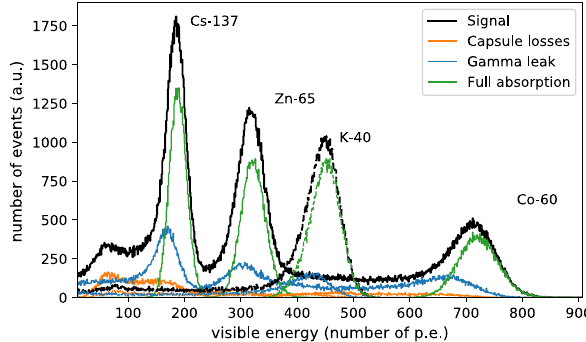
Fig. 12 Simulation of the visible energy spectra (in number of photo electrons) of the gamma sources placed off-axis at a radius of 1.2 and 1.2m over the detector center. The dashed line represents the signal of the 40 K capsule, the solid line of the multi-gamma source. The absorption peaks of the individual isotopes are clearly discernible. The observed spectrum can be understood as a combination of events with full absorption in the LS ( green ), with energy loss in the capsule ( orange ) and with energy loss from spill-out from the AV volume ( blue